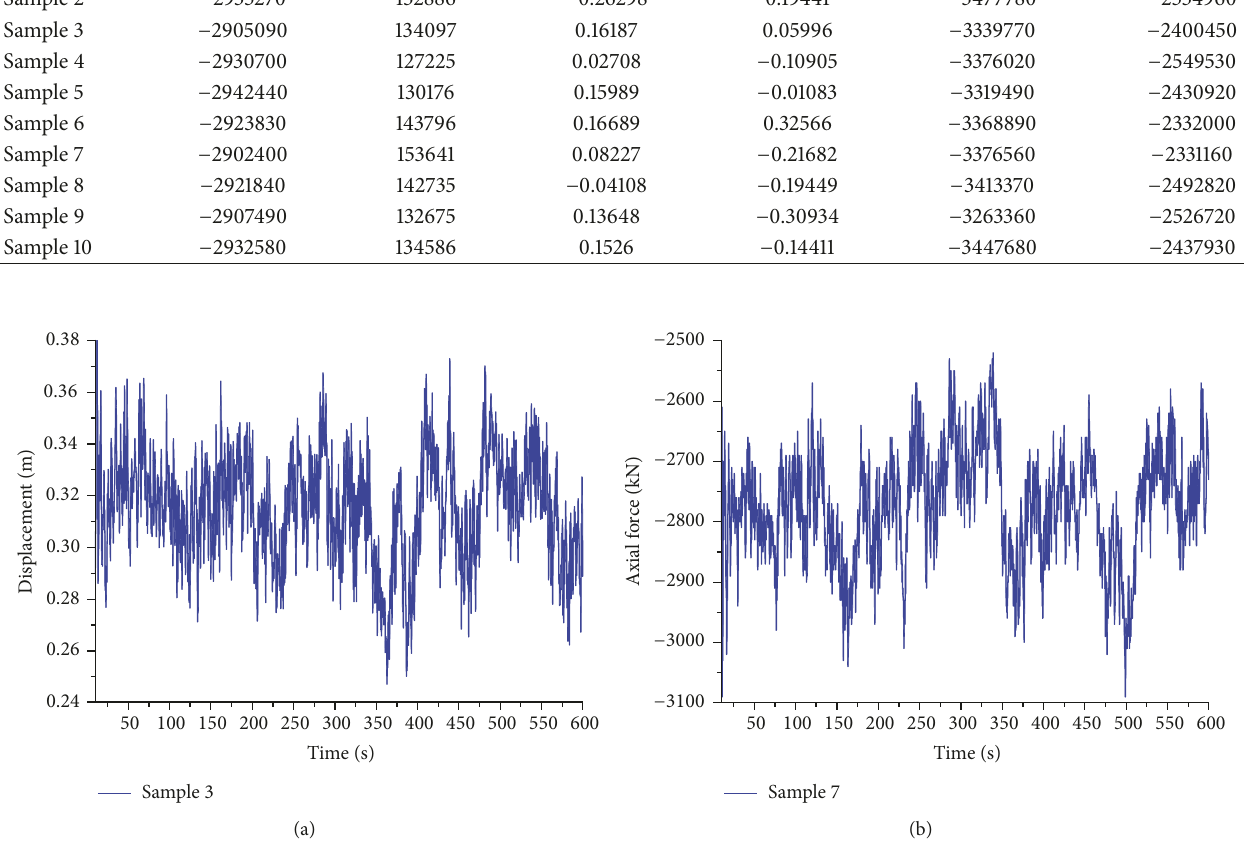
Figure 11: Time history curve of high tower in the tower-line system under wind field 2.